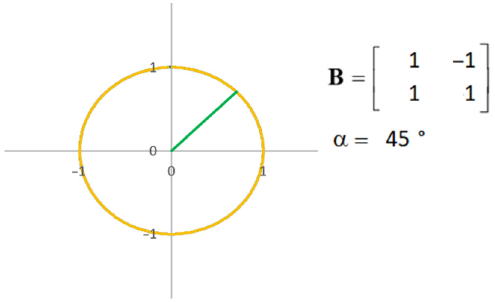
Figure 9. General tensor with 𝛼 = −10° . Figure 10. General tensor with 𝛼 = −45° . Components of this rotational matrix can be a part of some general tensor. Upon de- fining the square matrix components, the matrix can be decomposed into symmetric and antisymmetric tensors. Typically, for this tensor, the initial angle always equals 𝛼 = 45° . However, with every rotation of the rotational matrix by angle 𝜑 , a new general tensor emerges. Figures 11–14 show examples of different tensors corresponding to some of the rotational matrix states. Figure 11. General tensor for rotational matrix with angle 𝜑 = 0° .